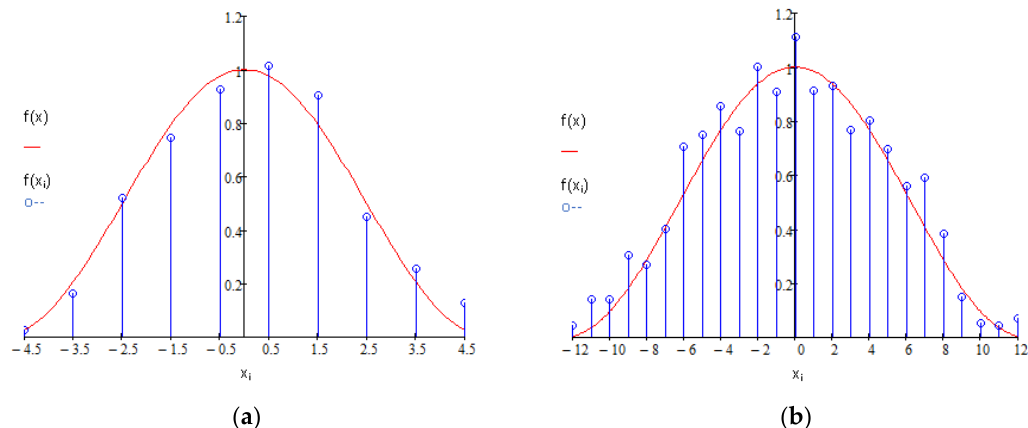
Figure 2. Example of the pulse signal functions f(x) and sample sets f(x i ) used in the simulations. The plot was drawn for ( a ) even ( A = 1, τ = 50 ns, f s = 50 MHz, noise 𝜉(𝑥 𝑖 ) ∈ 𝑁(0,0.1) ) and ( b ) odd ( A = 1, τ = 50 ns, f s = 250 MHz, noise 𝜉(𝑥 𝑖 ) ∈ 𝑁(0, 0.1) ) numbers of samples.